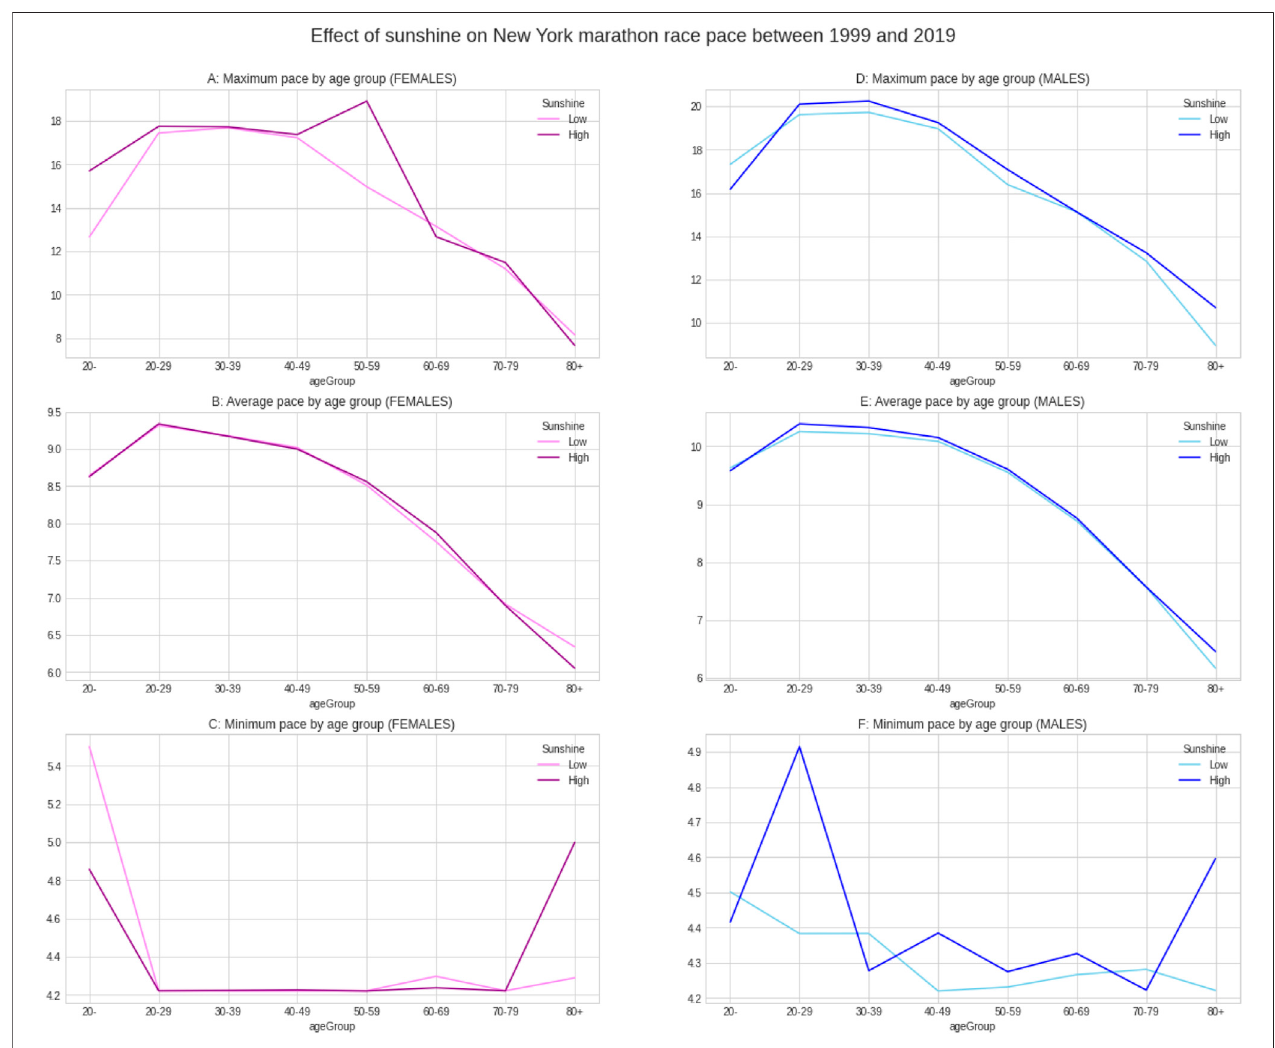
FIGURE 14 | Effect of sunshine on running speed by age